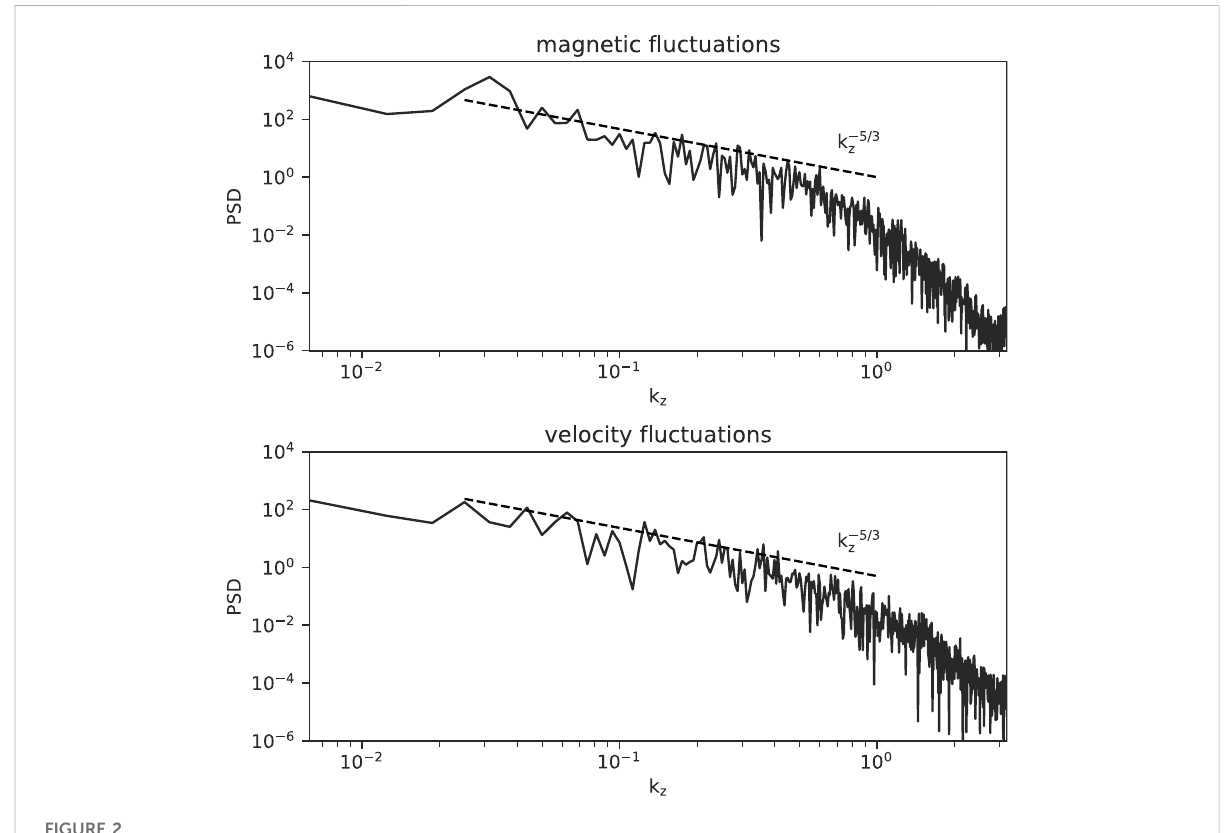
FIGURE 2 Power spectrum density of magnetic and velocity fl uctuations of the 2D case at t =